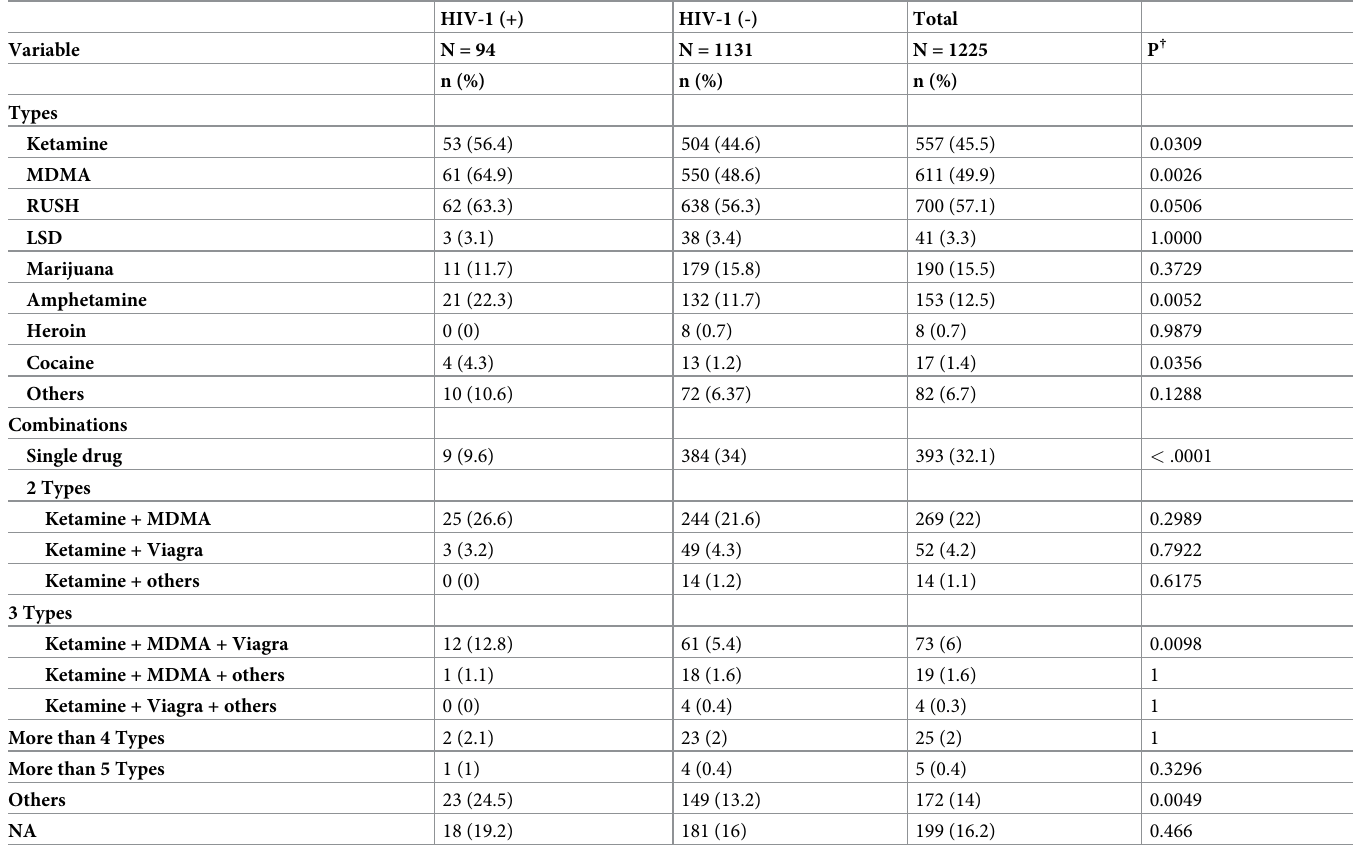
Table 5. Distribution of different types or number of recreational drugs usage among MSM in Taiwan in